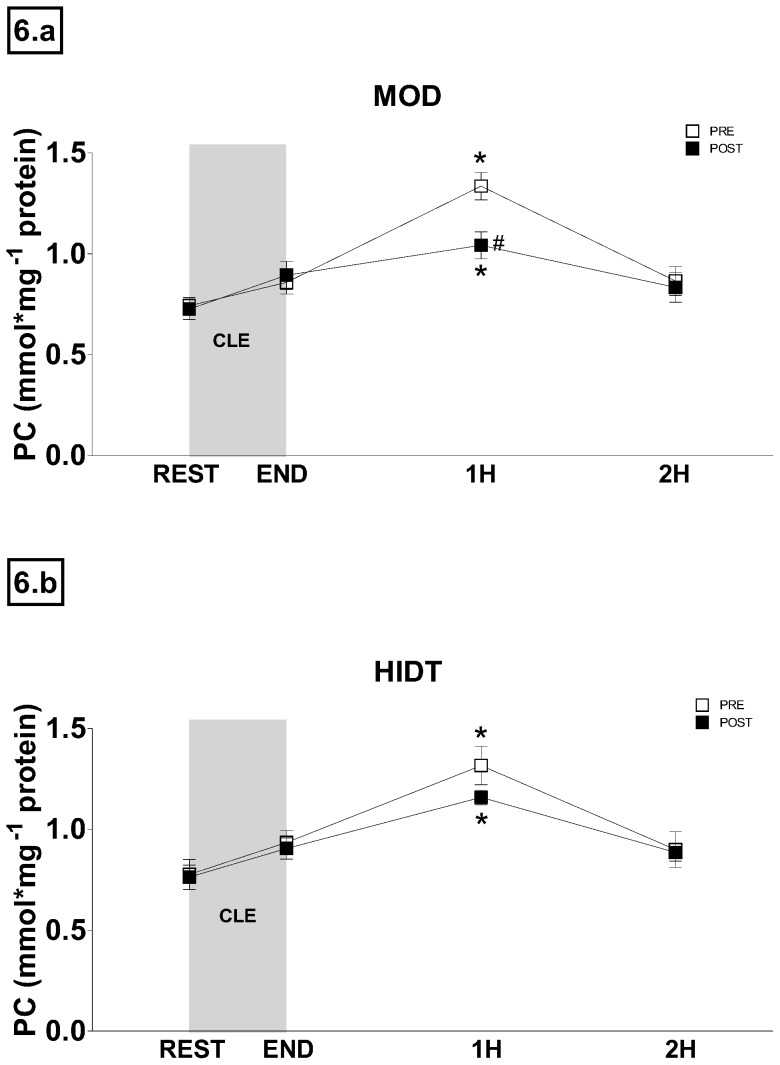
Time course changes of PC concentration recorded before (REST) and after (END, 1H and 2H) constant-load submaximal exercise trials (CLE).White squares indicate pre training (PRE) values and black squares post-training (POST) values. Values are expressed as means ± SD. *P<0.05 compared to basal value. #P<0.05 compared to PRE.